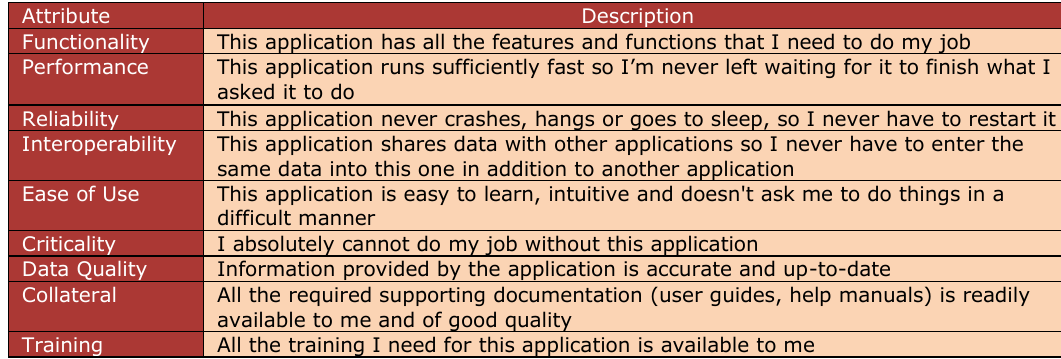
Table 3. Attributes description